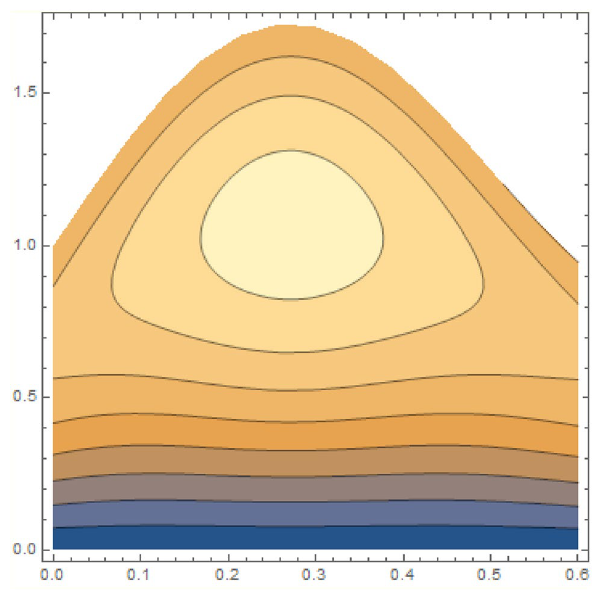
Figure 22. Streamlines of K = 2.5.